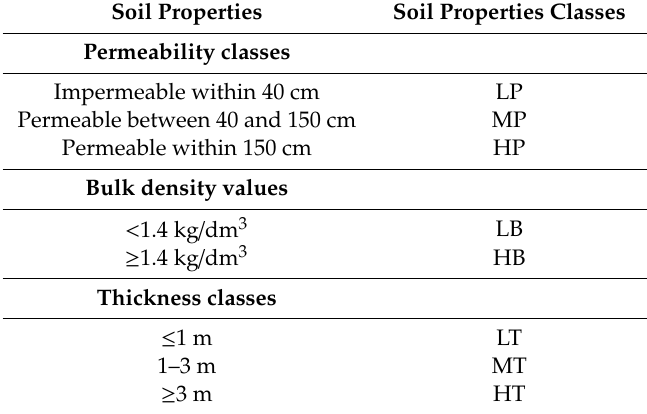
Table 2. Soil properties classification used for determining the soil stability conditions. The classes and the values of the properties (permeability, bulk density and thickness) are divided in categories (See text for details). LP = low permeability. MP = medium permeability. HP = high permeability. LH = low bulk density. HB = high bulk density. LT = low thickness. MT = medium thickness. HT = high thickness.